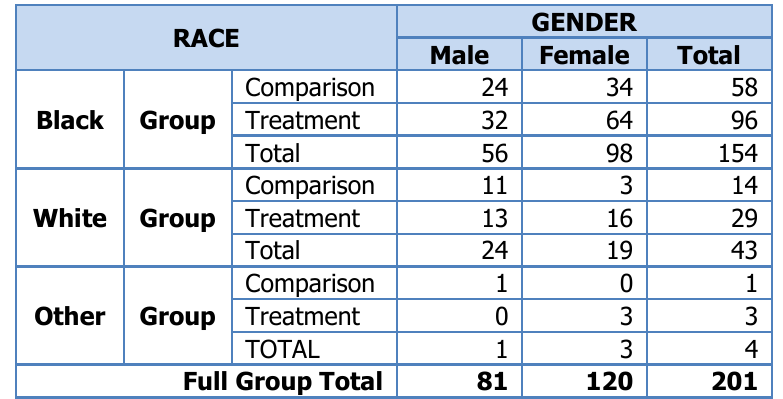
Participant Demographics by Study